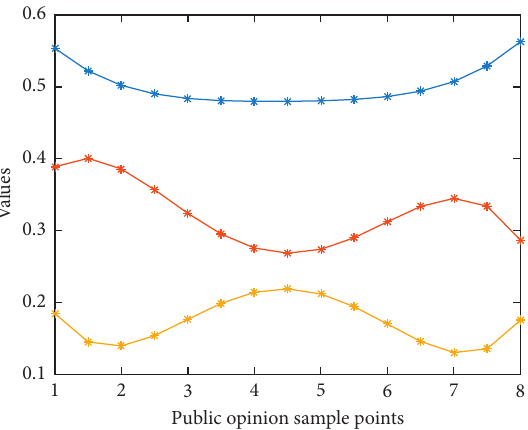
Figure 7: Satisfaction survey of the public policy and public opinion system based on the Markov